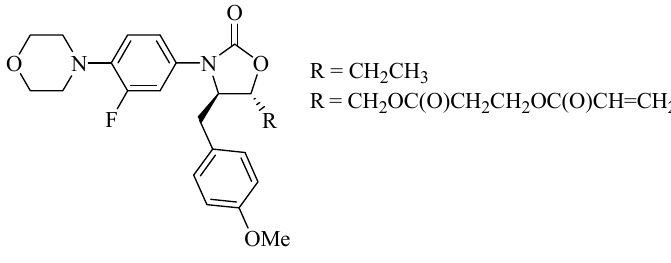
Figure 3. Oxazolidinone compounds 4,5-di-substituted with anticancer activity.